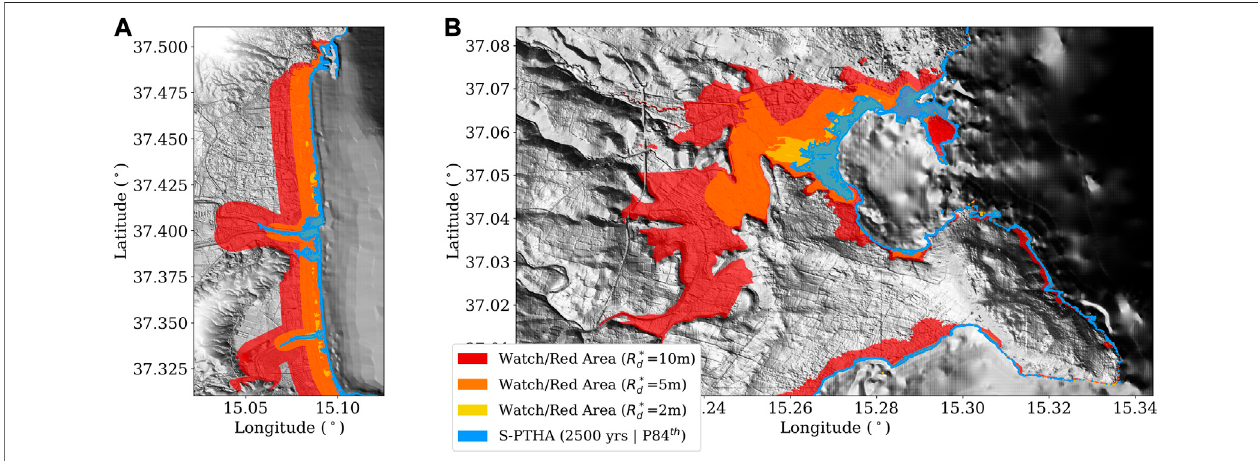
FIGURE 10 | Watch/Red areas designed for different values of R p d (2, 5 and 10 m, in red, orange, yellow and blue, respectively) compared to the local SPTHA inundation corresponding to 2,500 years ARP and the 84th percentile (blue) in Catania [panel (A) ] and Siracusa [panel (B) ].